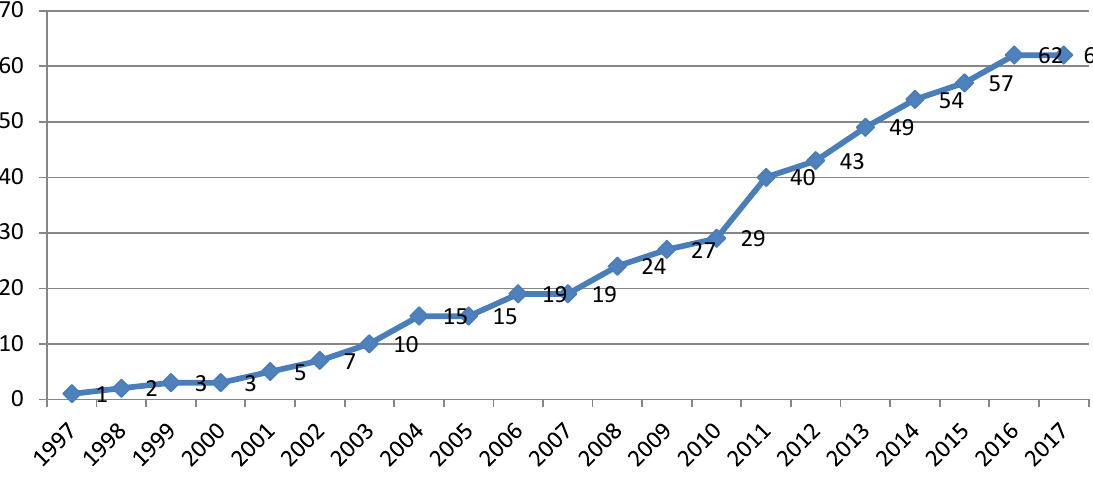
Figure 1. The proportion of adult Internet users (18+) in Ukraine, %